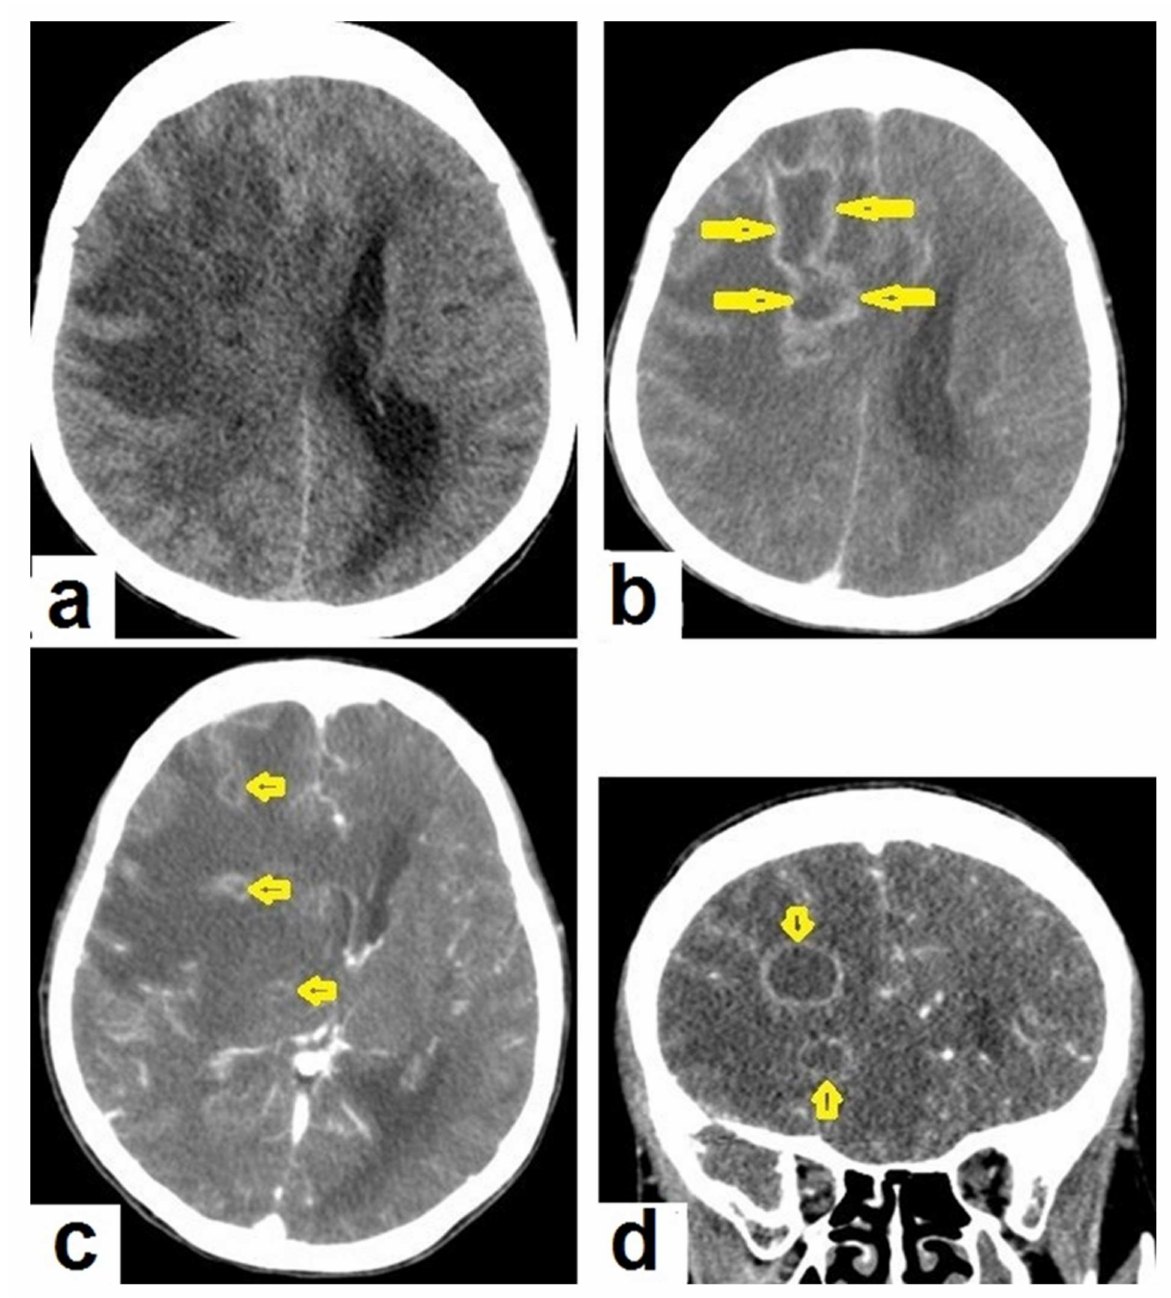
Figure 15. Tuberculous abscesses and tuberculomas in a 70-year-old woman with disturbance of consciousness and long history of headache. Selected axial computed tomography (CT) images of the brain ( a ) axial non-enhanced CT show significant vasogenic edema in the frontal and parietal lobes of the right cerebral hemisphere, with severe mass effect manifested as loss of the cortical sulci, total effacement of the right lateral ventricle and mild midline shift to the left side. ( b ) Contrast-enhanced CT (CECT) shows loculated rim-enhancing lesion centered in the right frontal lobe measures about 39 mm × 16 mm × 12 mm, suggesting cerebral abscess (arrows). ( c ) Axial CECT shows multiple ring- enhancing lesions in the right cerebral hemispheres and right basal ganglia (short arrows) suggesting of cerebral abscesses or tuberculomas. ( d ) Coronal CECT shows multiple ring-enhancing lesions in the right cerebral hemispheres (short arrows), suggesting cerebral tuberculomas or